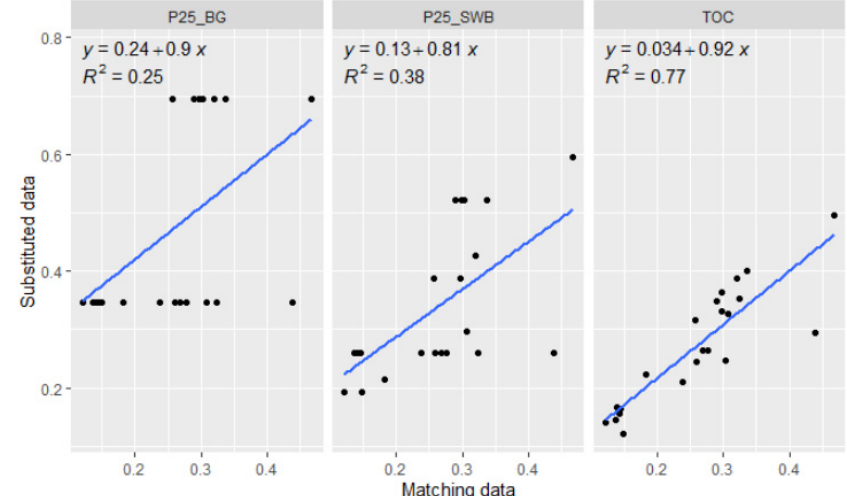
Figure 11. The comparison of the M-BAT calculated RCR for Pb between the matching data and substituted data (P25_BG—the 25th percentile of the available DOC data and/or the DOC data calculated by the TOC from the Bulgarian monitoring network results during 2020; P25_SWB—the 25th percentile of the DOC data calculated by the TOC for the respective water body; TOC—the matching DOC data calculated by